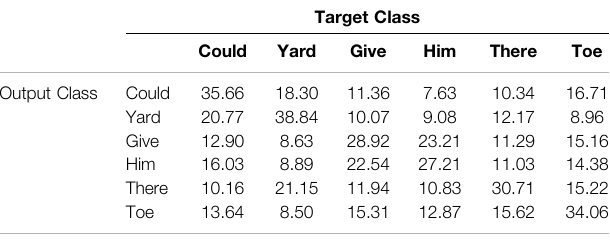
TABLE 5 | Confusion matrices obtained for subject 2 after classi fi cation with SVM classi fi er.